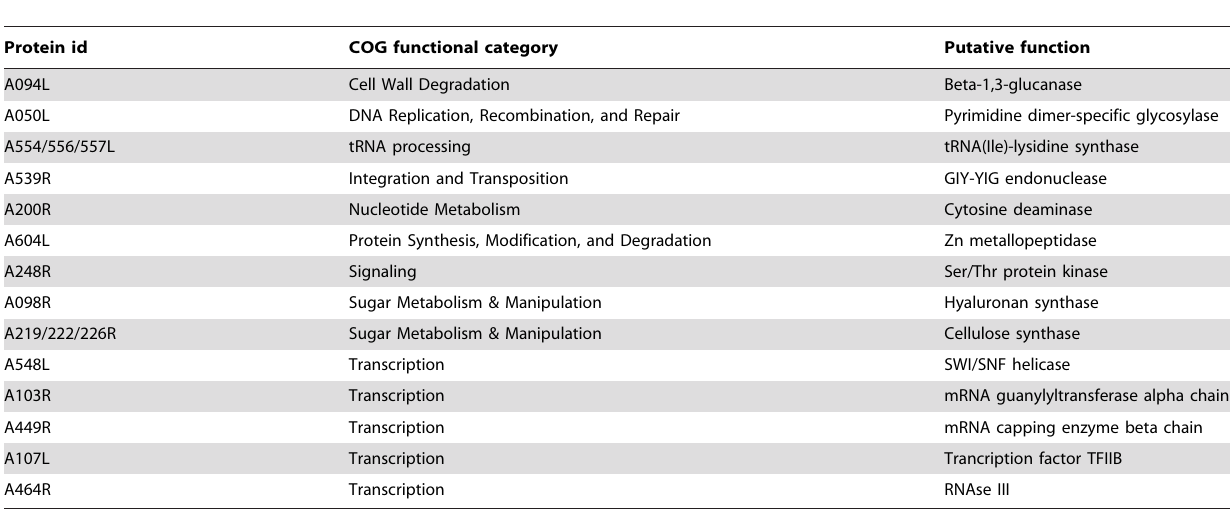
Table 1. Members of the top-50 PBCV-1 genes transcribed during the first 7 min p.i. that have a known function.